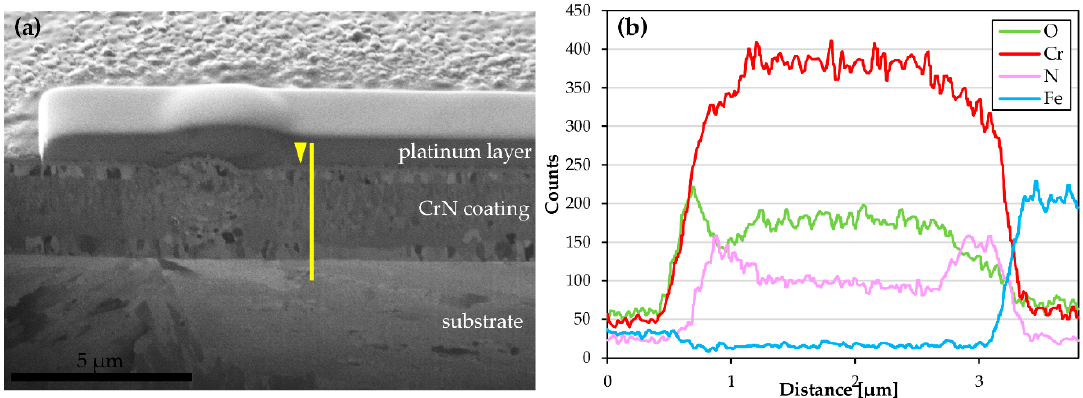
Figure 8. CrN coating in annealed state, ( a ) ion induced secondary electron image of CrN coating cross-section in the annealed state, ( b ) chemical composition obtained by EDS analysis along the line depicted in the image (a).